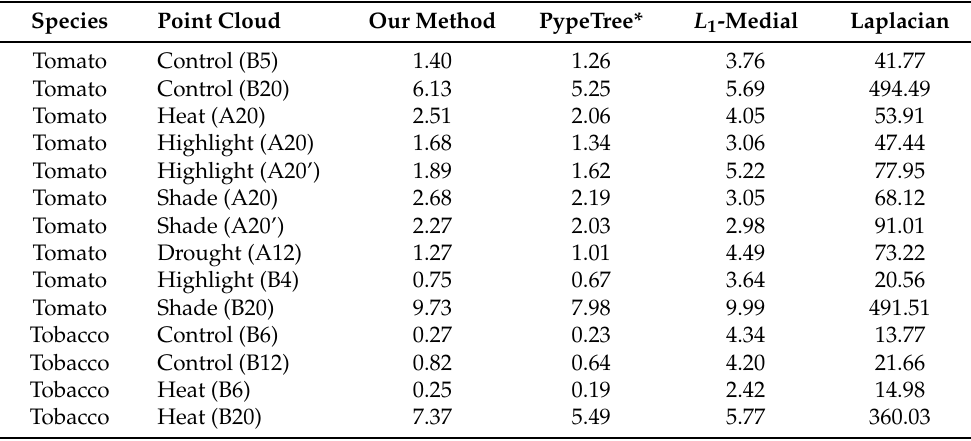
Table 1. Run-time comparison for all methods. All measurements shown are in seconds. Species Point